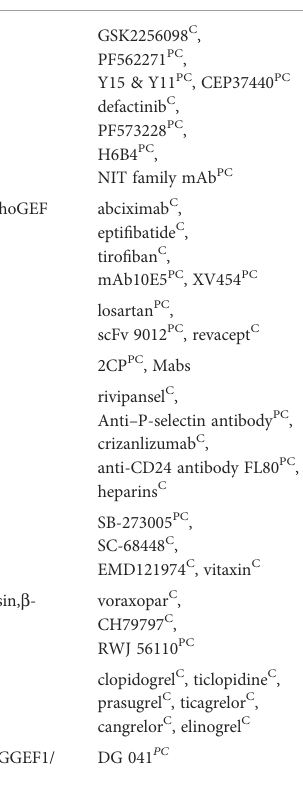
TABLE 1 Platelet inhibitors and anticoagulants in cancer therapy.